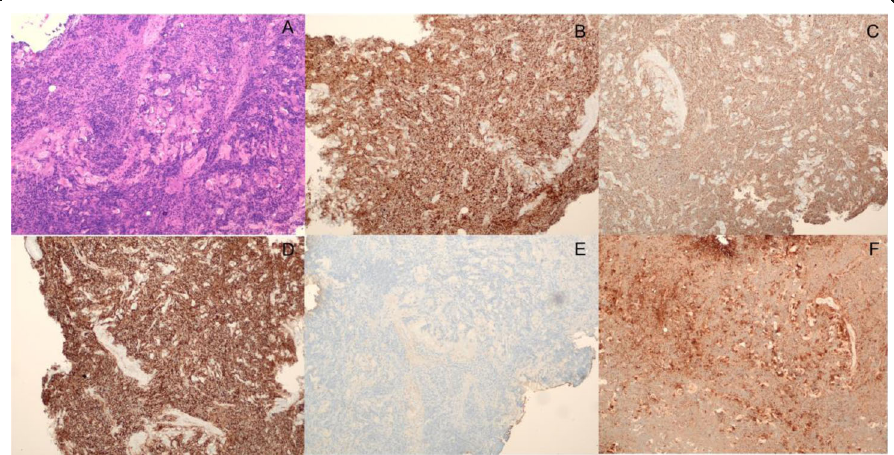
Fig. 2 a Histology revealed monomorphic proliferation of atypical cells with basophilic nucleus. CD38 and CD138 immunoreactivity was found, respectively, confirming plasma cell differentiation ( b - c ), and